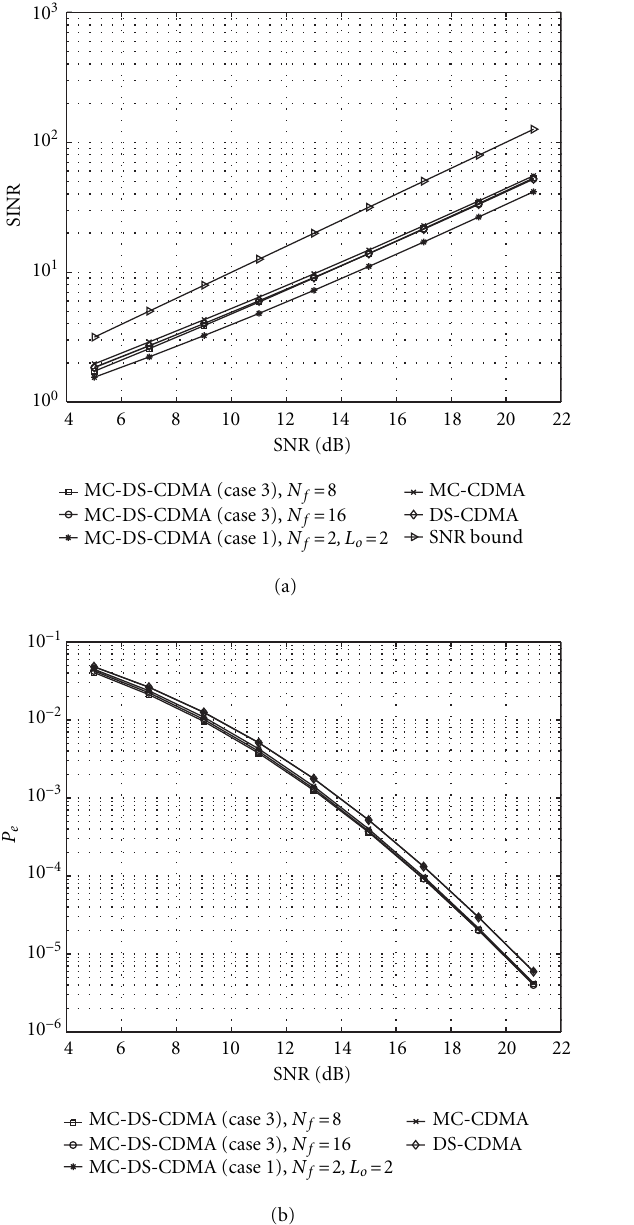
Figure 7: Performance of various equivalent systems over an FS channel for K = 20 users as a function of SNR. (a) SINR. (b) P e .